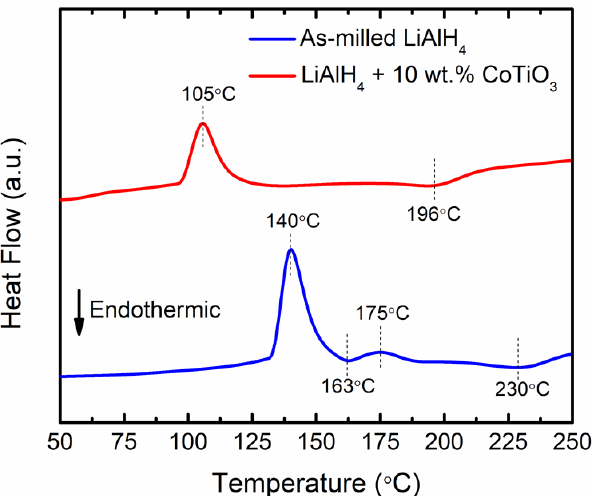
Figure 3. DSC profile of as-milled LiAlH 4 and LiAlH 4 + 10 wt.% CoTiO 3 (heating rate: 15